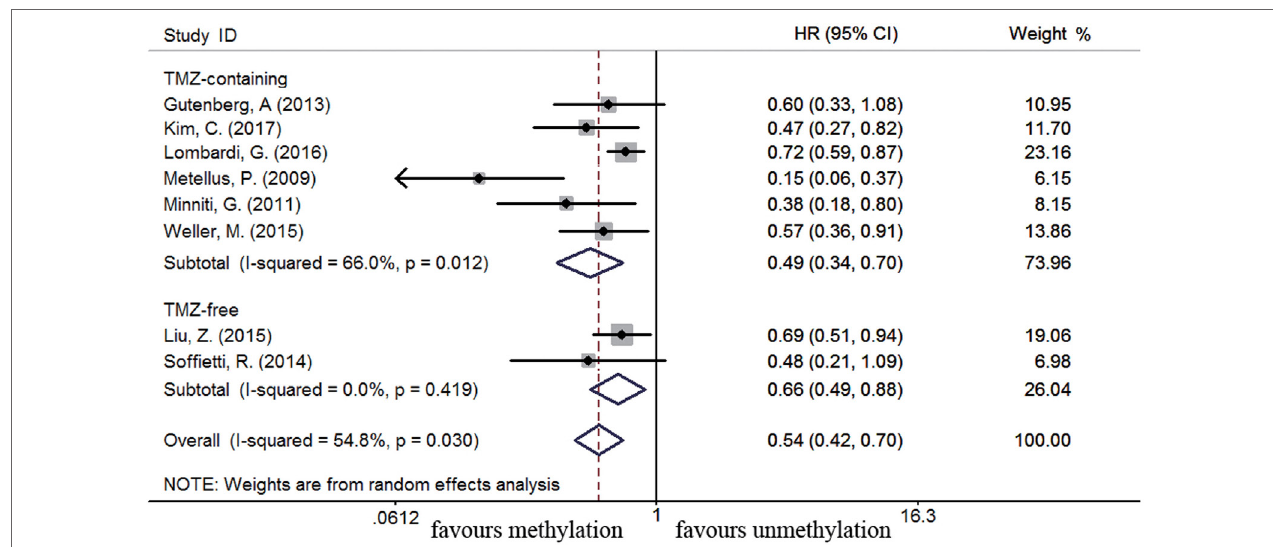
FiGURe 10 | Calculated HR and 95% CIs for the relationship between methylation and PFS benefit from TMZ-containing or TMZ-free therapy in recurrent GBM patients (methylated vs. unmethylated